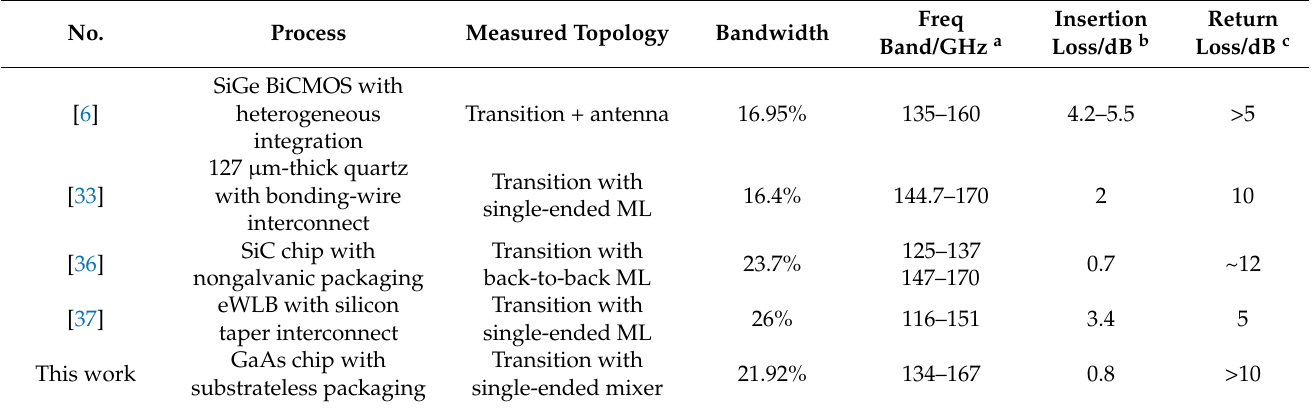
Table 4. Measurement comparison of D-band transitions.